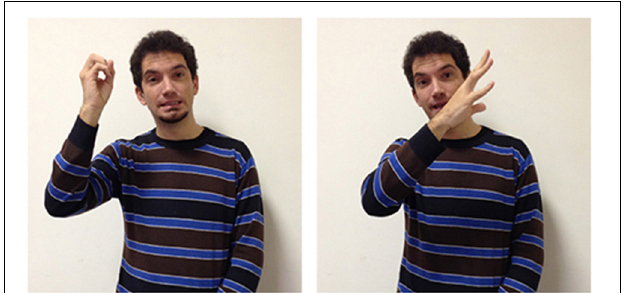
FIGURE 4 | LIS sign TO FORGET .